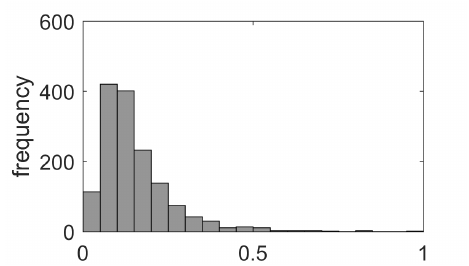
Figure 12. The distribution of reduction factor α